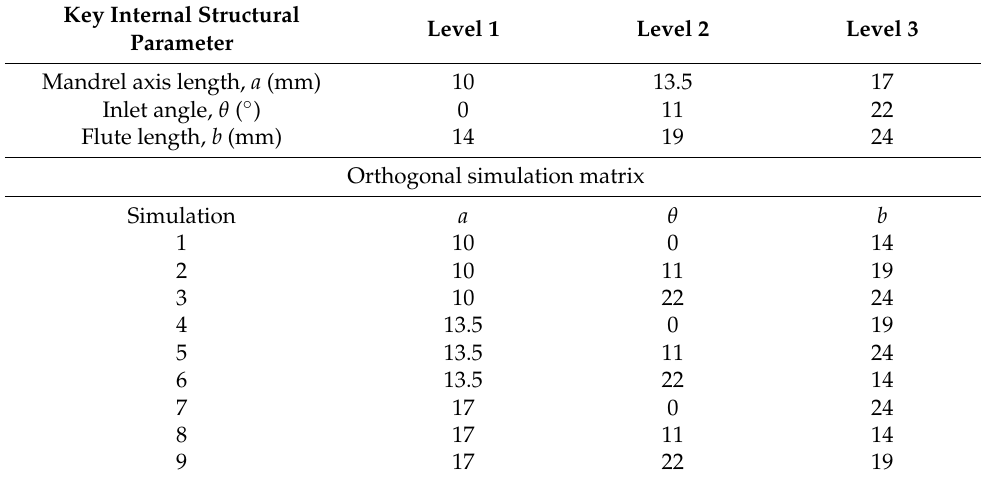
Table 1. Orthogonal experimental matrix for printhead